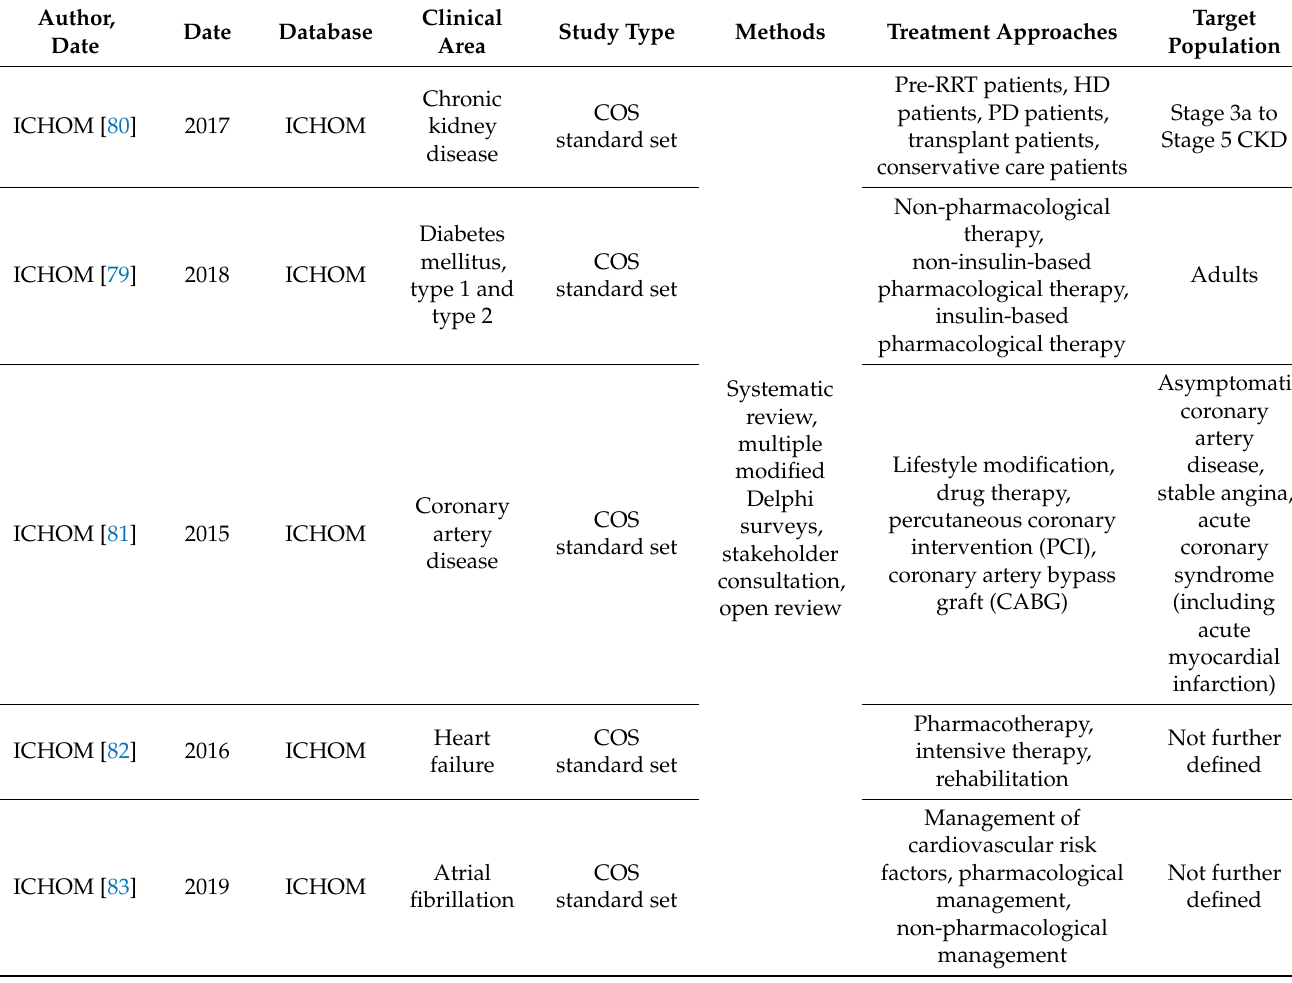
Table 2. Core outcome set study